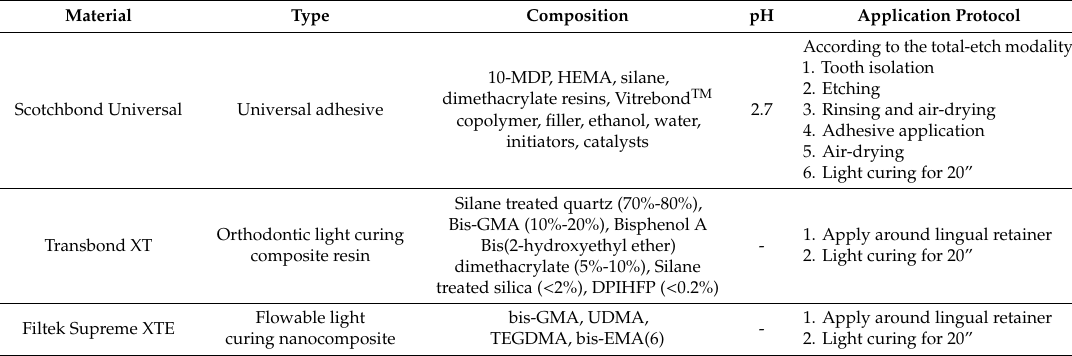
Table 1. Materials used and protocol recommended for their